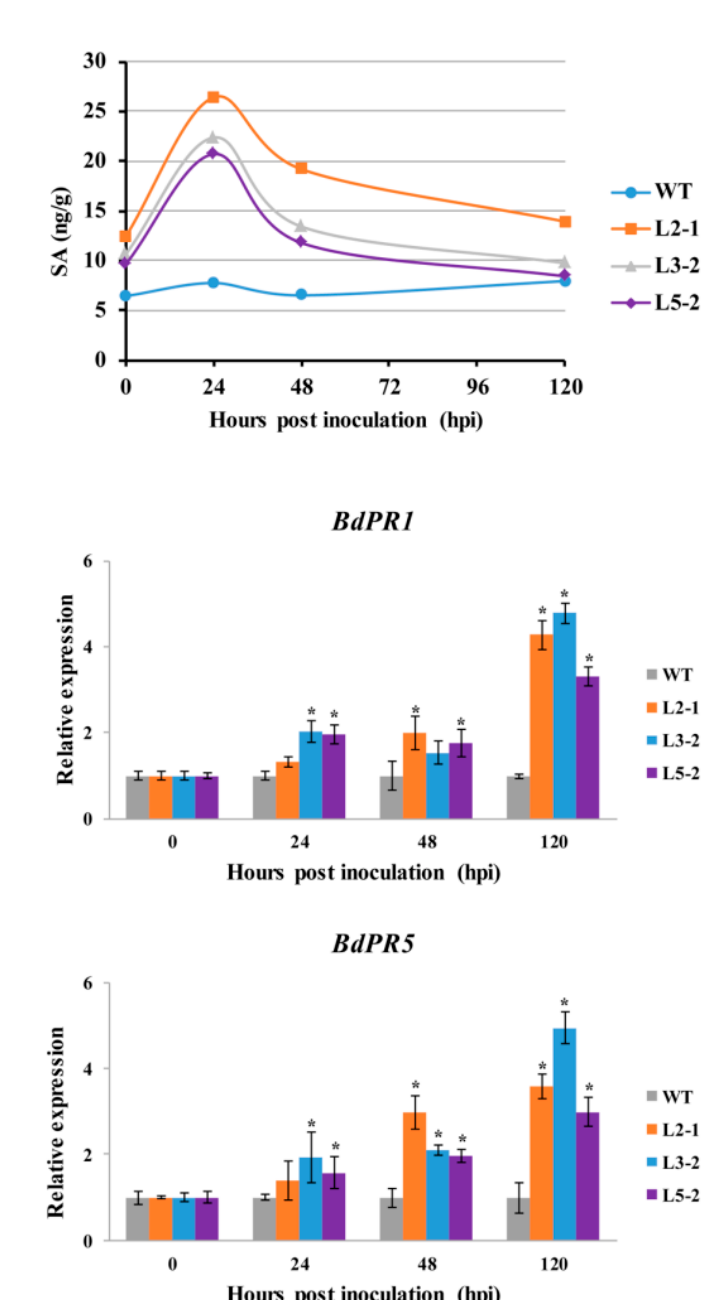
Figure 4. Detection of SA levels and defense-related genes in AtSAG101 transgenic plants infected with Puccinia brachypodii . ( A ) SA accumulation in AtSAG101 transgenic leaves. ( B ) Transcript levels of defense-related genes in AtSAG101 transgenic leaves challenged with P. brachypodii . SA, salicylic acid; ng / mg, SA accumulation (ng) per fresh leaf weight (mg); WT, wild type plants; L2-1, L3-2 and 5-2, transgenic B. distachyon plants; B. distachyon ( Bd ) PR1 gene (upper panel) and BdPR5 gene (lower panel). *, p <